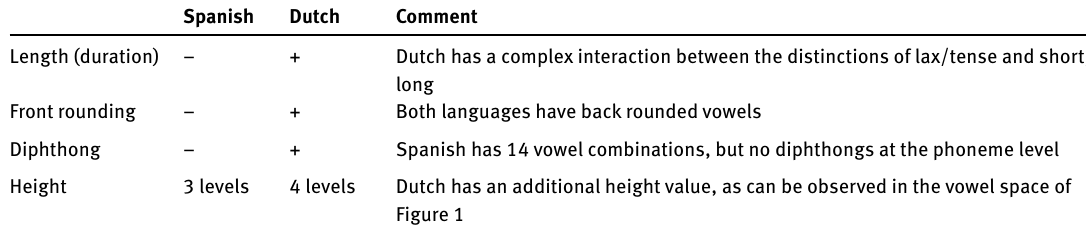
Table 1. Distinctive features of the Spanish and Dutch vowel systems. Spanish